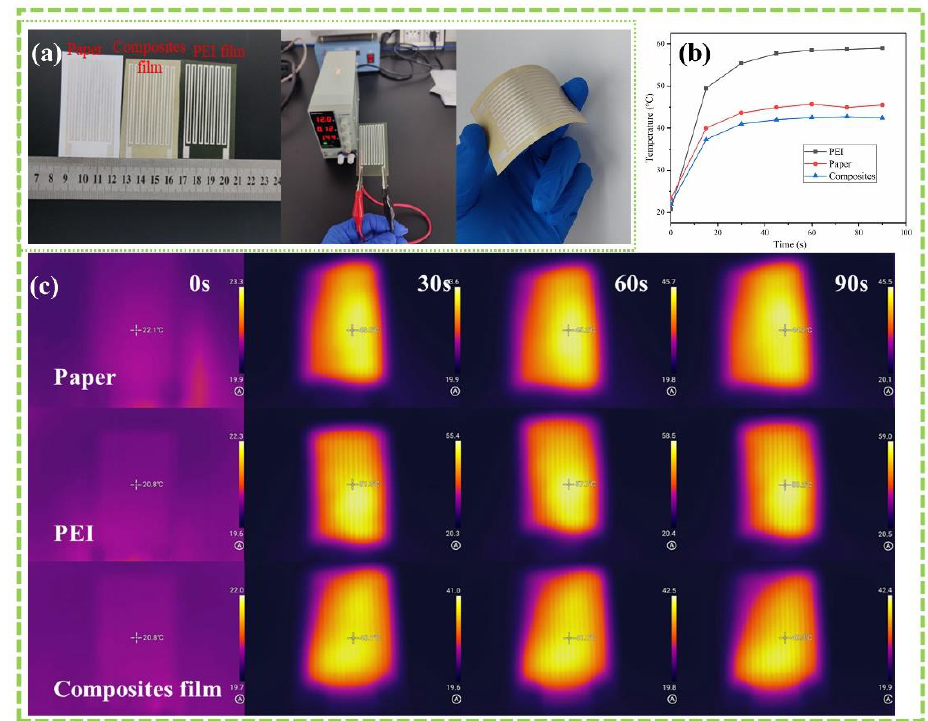
Figure 6. ( a ) From left to right: optical photographs of flexible circuits integrated into paper, PEI, and composite film; applying voltage; and bending the flexible substrate. ( b ) Surface temperature versus time. ( c ) Infrared thermal images.